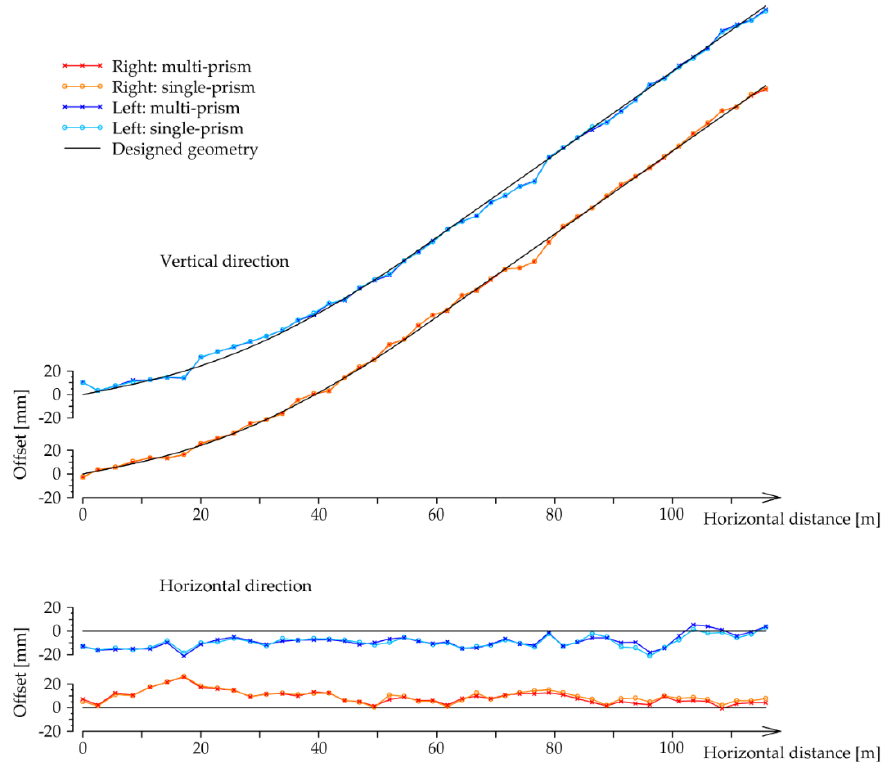
Figure 12. Offsets of the determined characteristic point 𝐂 from its designed value in the horizontal and vertical direction for both methods (single- and multi-prism) and both inrun tubes (left and right).